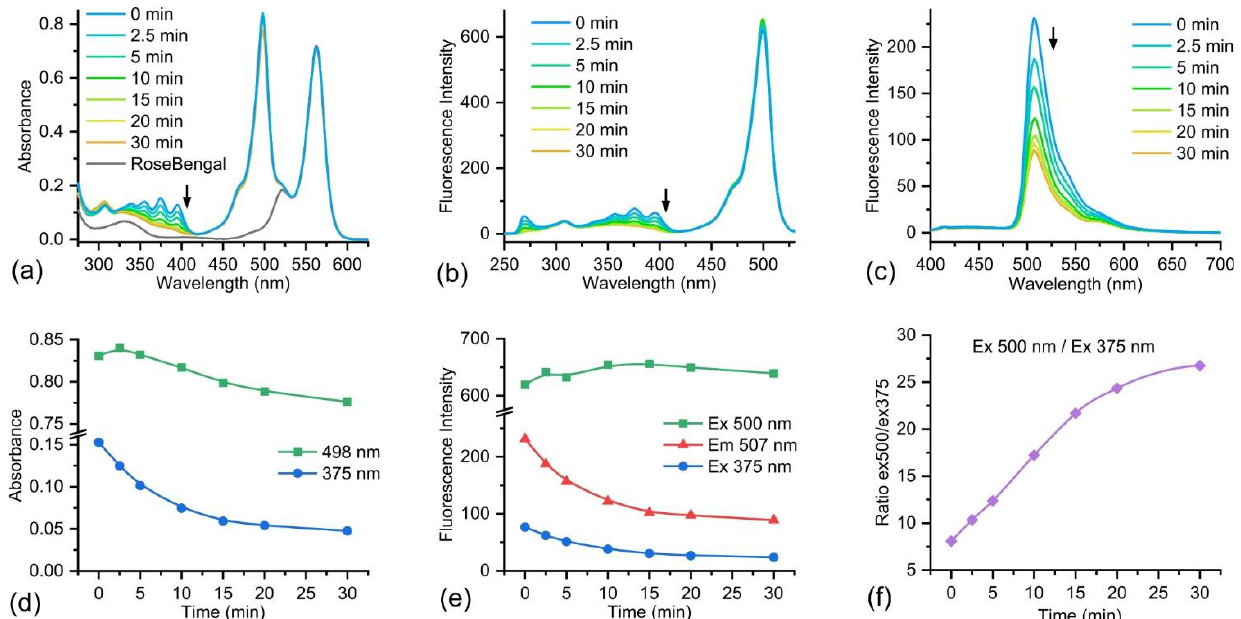
Figure 5. Absorption ( a ), fluorescence excitation ( b ), and fluorescence emission ( c ) spectra of BODIPY-DPA 11 in the course of singlet oxygen generation by RoseBengal. Spectra before and after green light irradiation for 2.5, 5, 10, 15, 20 and 30 min. Dynamics of absorption ( d ) and fluorescence ( e ) change at the specified wavelengths, as well as the ratio of fluorescence intensities when excited at 500 nm to 375 nm ( f ).